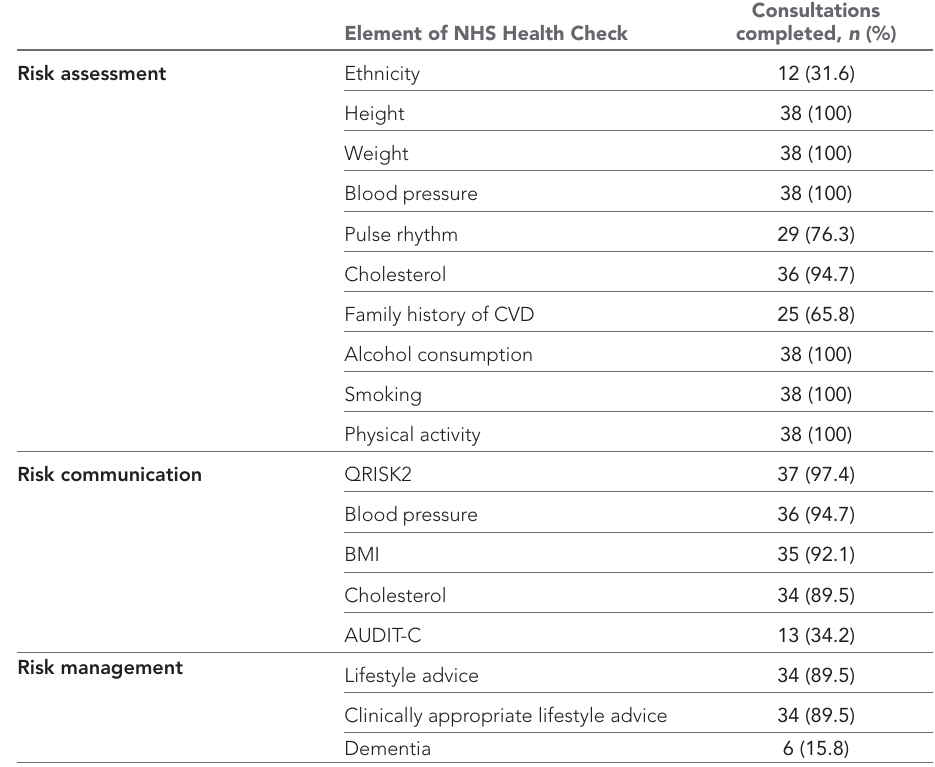
Table 4 Fidelity by NHS Health Check element Element of NHS Health